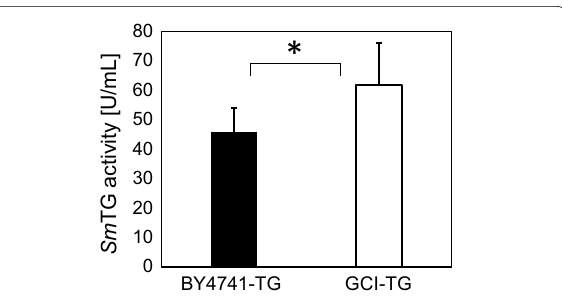
Fig. 2 Effect of reduced glutathione (GSH) addition on polymerization of caseinate by Sm TG. The concentration of proteins whose molecular weights were more than 100 kDa were detected after polymerization of caseinate by 0.2 BY4741‑TG strain in the presence of different GSH concentrations